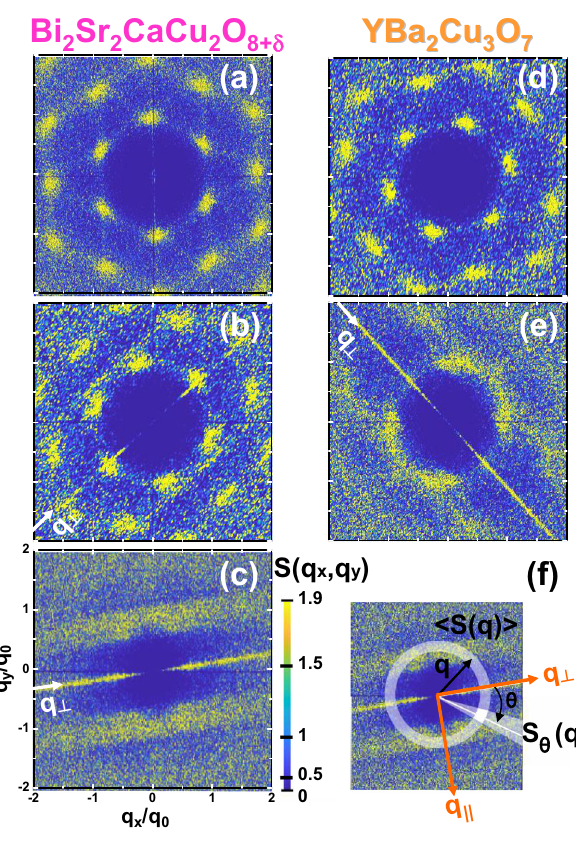
Fig. 2 Structure factor of vortices nucleated in type-II superconducting samples with point and planar disorder. Data in Bi 2 Sr 2 CaCu 2 O 8 + δ samples with ( a ) point disorder, ( b ) few and ( c ) many planar defects (9,200, 2,000 and 35,000 vortices). Data in YBa 2 Cu 3 O 7 samples with ( d ) point disorder and ( e ) many twin boundaries (2,300 and 4,000 vortices). The color-scale is cuadratic (see bar) and wavenumbers are normalized by the Bragg wavenumber q 0 = 2 π / a with a the average distance between fi rst-neighbor vortices. f Schematics of the computation of the angularly-averaged 〈 S ( q ) 〉 and angular S θ ( q ) structure factors: Pixels considered to obtain these magnitudes are highlighted as a donut and an angular section, respectively. Shown are the wave-vector q , angle θ , and the reciprocal-space directions q q ∥ and ⊥ . S 1 ( q ∥ ) data shown in Fig. 4(b). In the q → 0 limit the tendency to ð q Þ (cid:2) q β saturation is evident: A fi t of S yields β ≈ 0 within the k k 1 error for the two studied compounds.